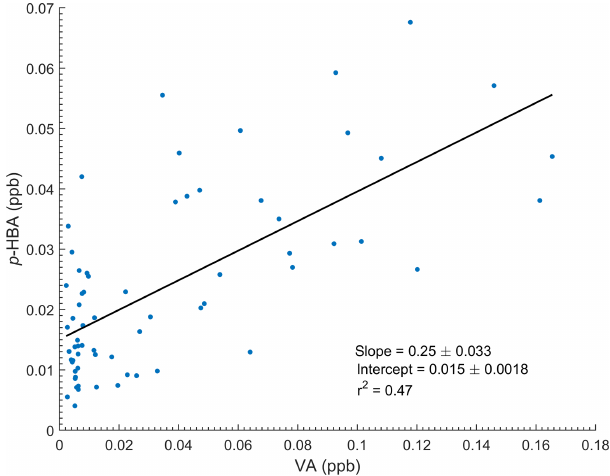
Figure 5. Comparison of vanillic acid and para -hydroxybenzoic acid records. Linear fit is the 40-year bin-averaged log transform of vanillic acid against the 40-year averaged log transform of para - hydroxybenzoic acid.